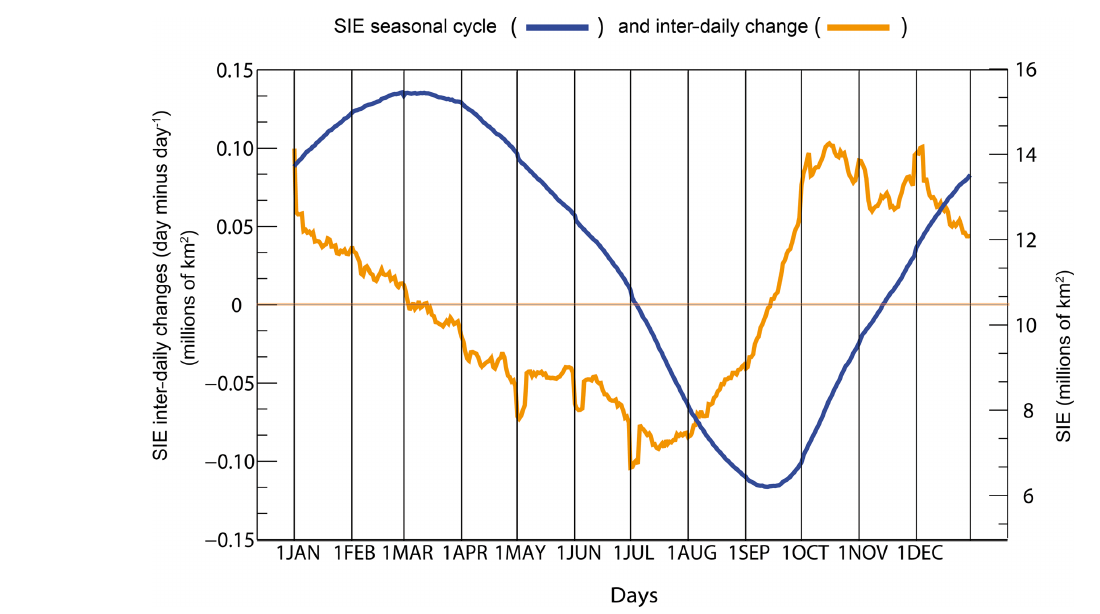
Figure 8. SIE seasonal cycle (blue line) and SIE inter-daily change (orange line).